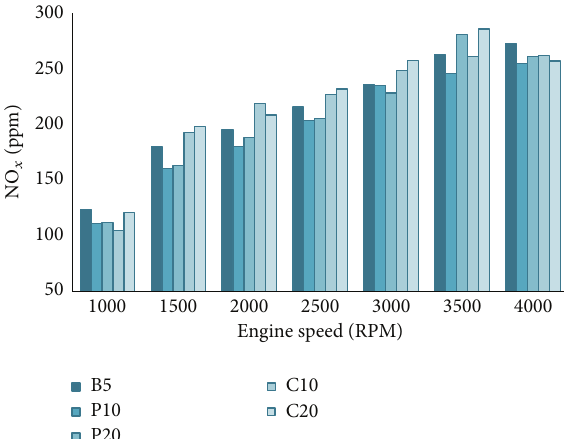
Figure 8: NO 𝑥 emission characteristics of all tested fuel blends at 100%